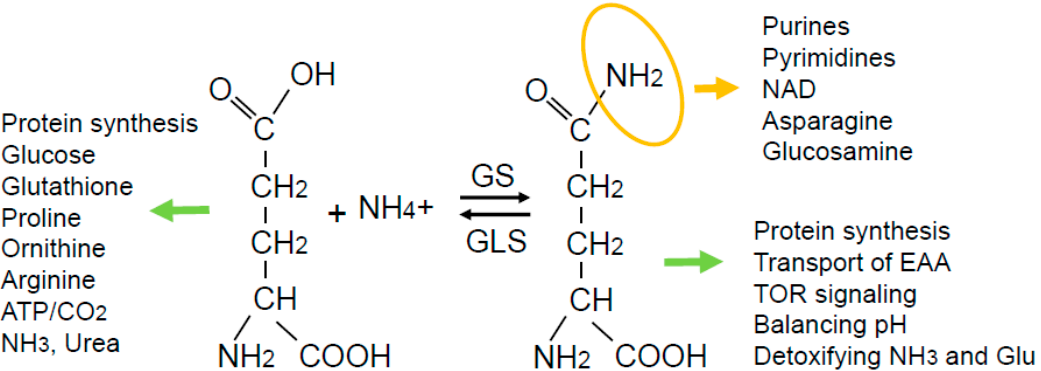
Figure 1. While glutamine can be converted to glutamate to exert functions indicated on the left-hand side, glutamine has its own specific functions: (1) The terminal amide group in glutamine (highlighted in orange) is the primary nitrogen source for several macromolecules; (2) the entire glutamine molecule can function to drive the uptake of essential amino acids (EAA) and activate mTOR; (3) the glutamine synthesis reaction can help balance pH and detoxify ammonia and glutamate.